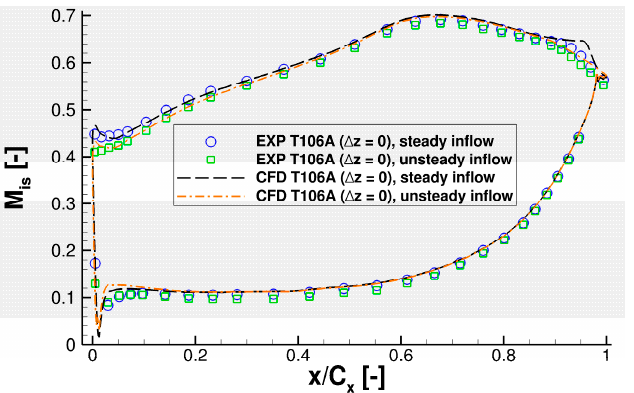
Figure 20. Comparison of the predicted and measured isentropic Mach number distributions at midspan of the T106A turbine cascade at M (cid:2915)(cid:2934)(cid:2919)(cid:2930),(cid:2930)(cid:2918) = 0.59, Re (cid:2915)(cid:2934)(cid:2919)(cid:2930),(cid:2930)(cid:2918) = 2 · 10 (cid:2873) . midspan of the T106A turbine cascade at M